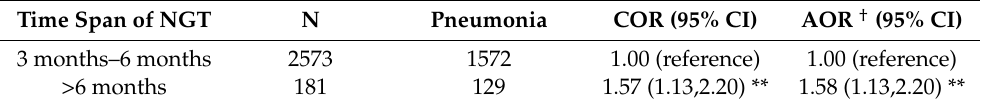
NGT: nasogastric tube; cOR: crude odds ratio; aOR: adjusted odds ratio; **: p -value < 0.01; †: adjusted for sex, age, resident area, and